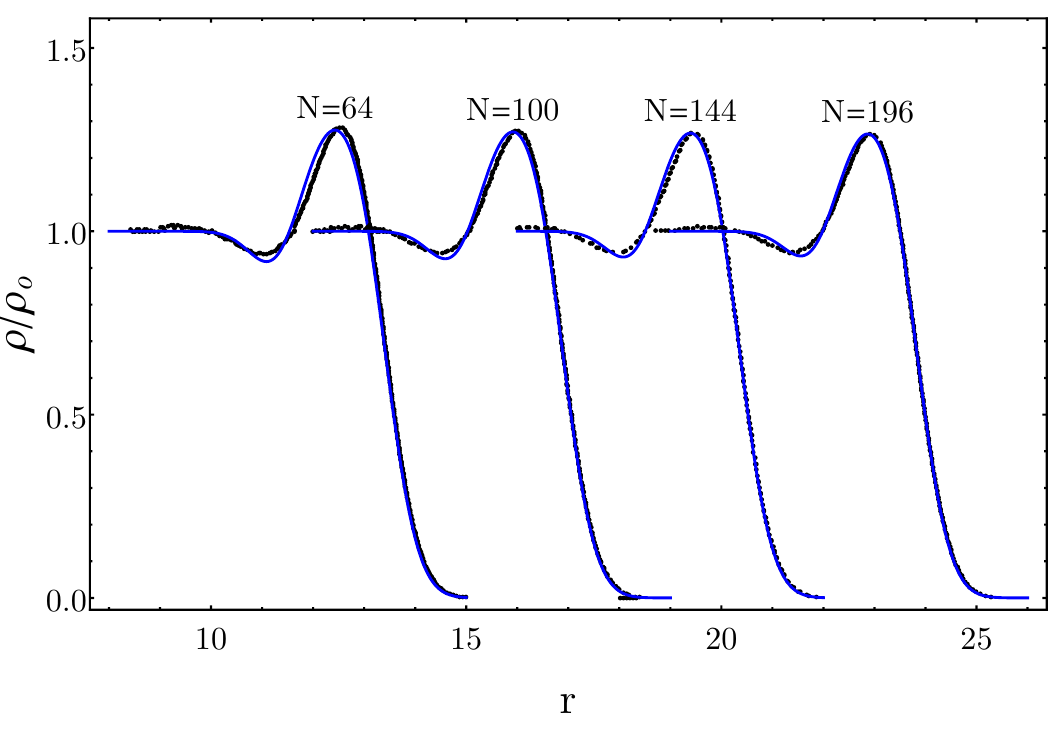
Figure 4 . Numerical density profile of the ν = 1 / 3 Laughlin ground state for N = 64 , 100 , 144 , 196 [49, 50] (black points) and two-block fit (blue).